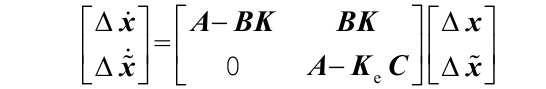
. Figure 6 is the response curve of the